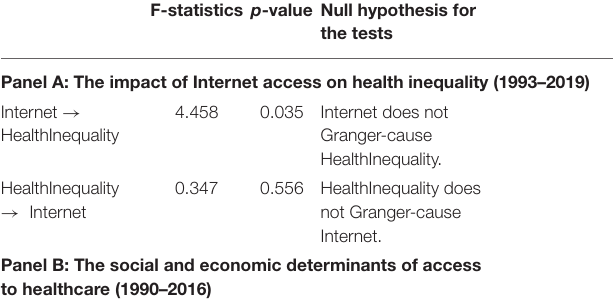
TABLE 6 | Panel causality